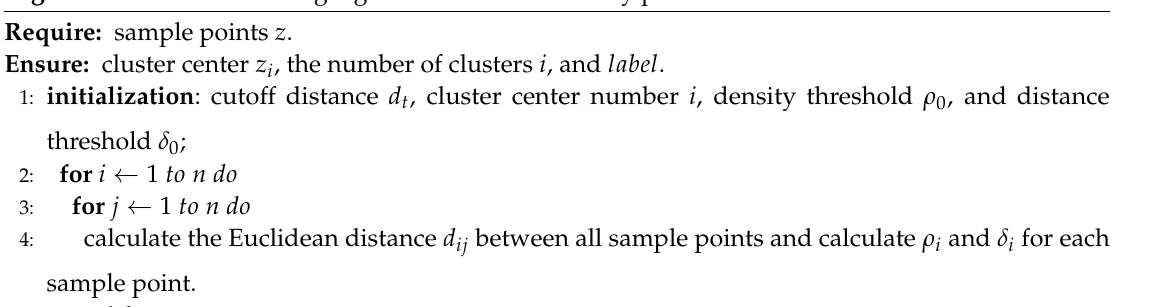
Algorithm 3 Initial clustering algorithm based on density